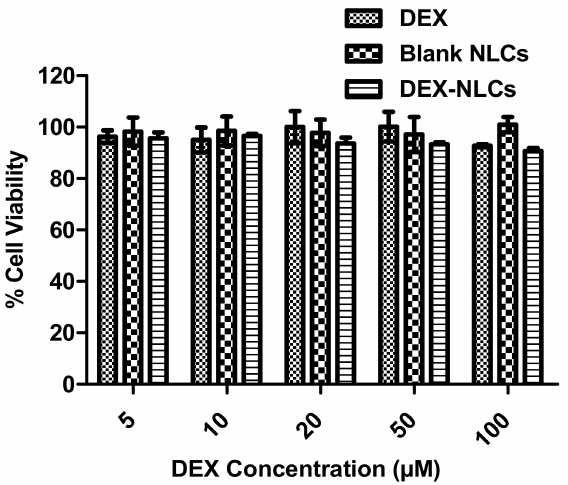
Figure 1. No toxicity was observed in HCECs cytotoxicity study for PSF-NLCs using DEX, blank NLCs and DEX-NLCs. Results represent n = 3 ±